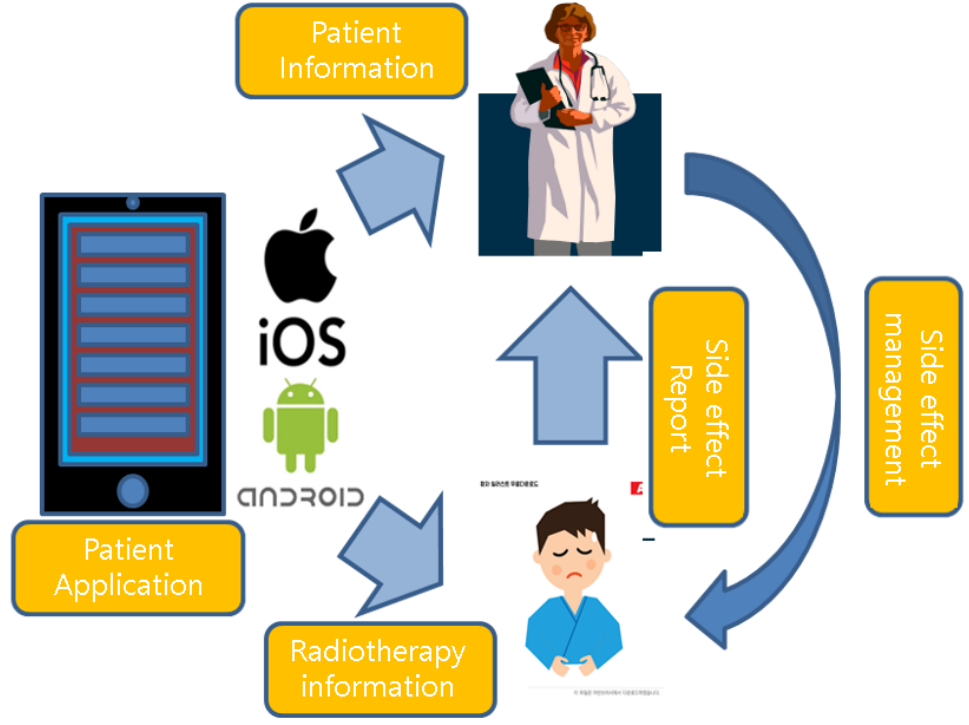
Figure 1. Two-way communication concept of the AROMA system .